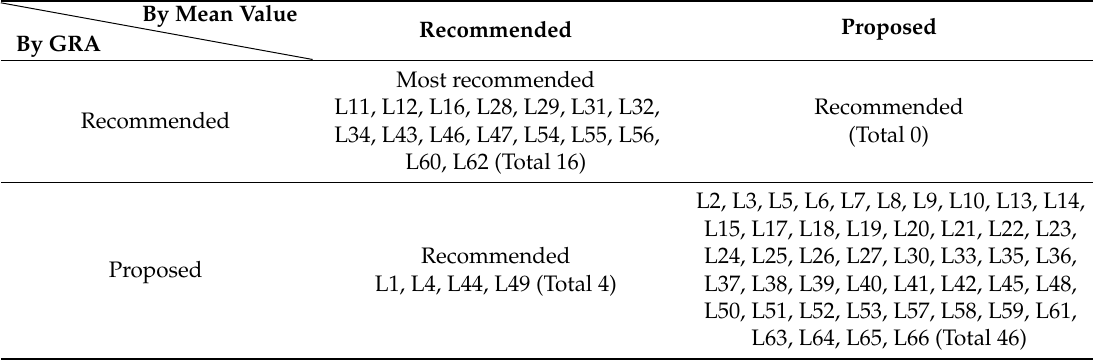
Table6. Thecrossrelationshipofrecommendedpicturesforhealthyimagesbythetwodi ff erentanalyses. By Mean Value By GRA